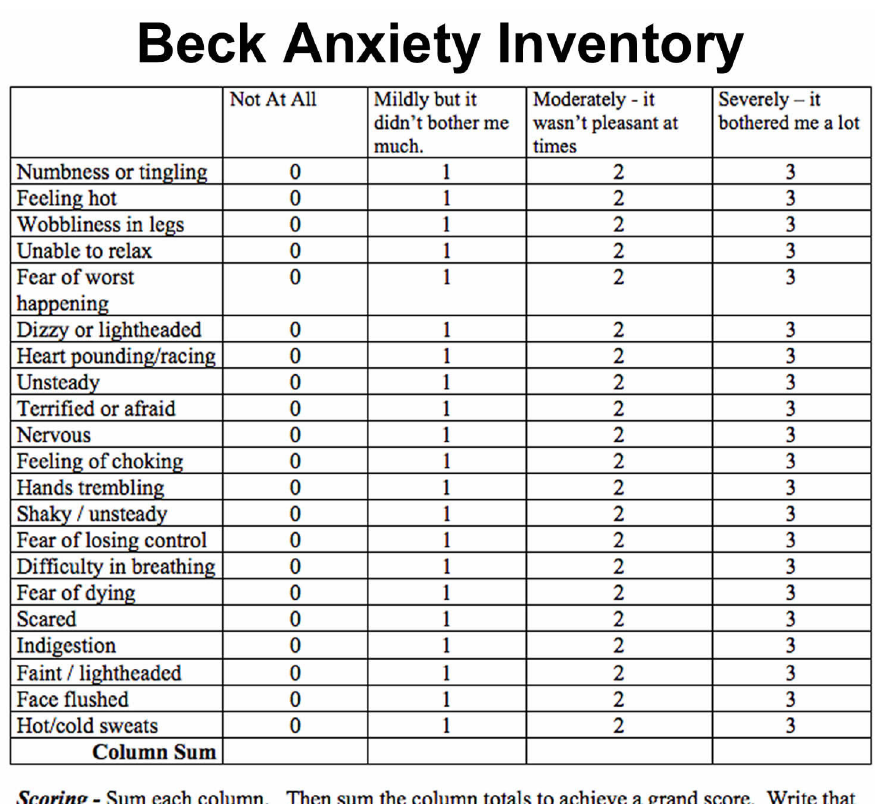
Figure 2. Beck’s anxiety scale in a 21-questionnaire format.